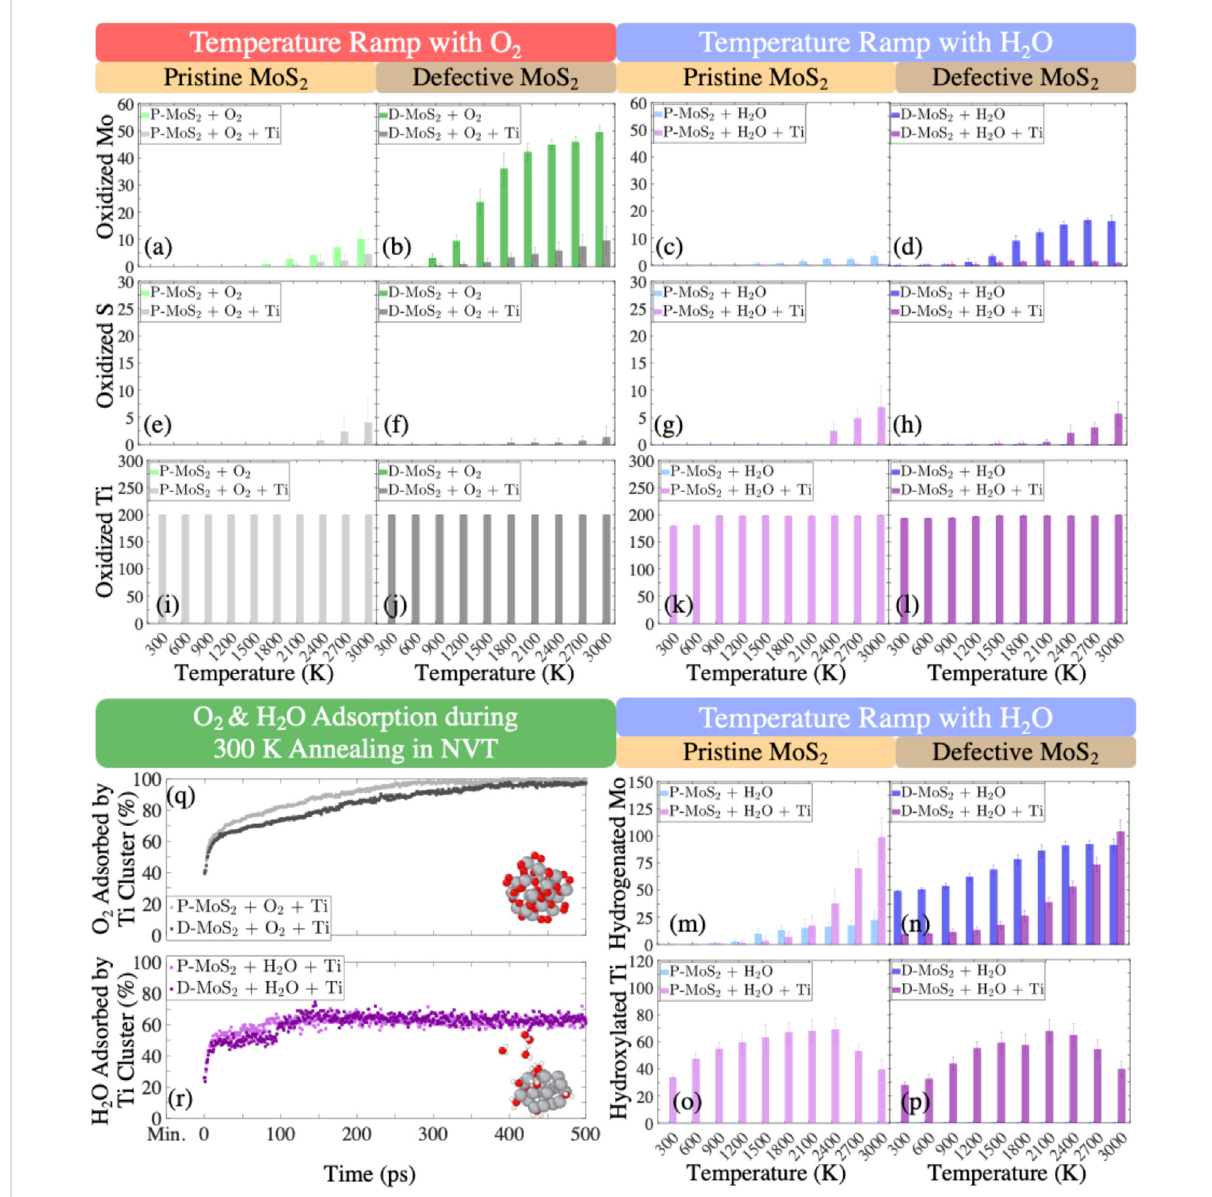
FIGURE 5 Evolution of oxidized Mo, S, and Ti atoms in the systems of (A) , (E) , and (I) pristine MoS 2 with O 2 (P-MoS 2 + O 2 ); (B) , (F) , and (J) defective MoS 2 with O 2 (D-MoS 2 + O 2 ); (C) , (G) , and (K) pristine MoS 2 with H 2 O (P-MoS 2 + H 2 O); (D) , (H) , and (L) defective MoS 2 with H 2 O (D-MoS 2 + H 2 O) quantifying the reactions during the temperature ramp. Evolution of hydrogenated Mo and hydroxylated Ti atoms in the systems of (M,O) P-MoS 2 + H 2 O as well as (N,P) D-MoS 2 + H 2 O quantifying hydrogenation and hydroxylation reactions during the temperature ramp. The percentages of